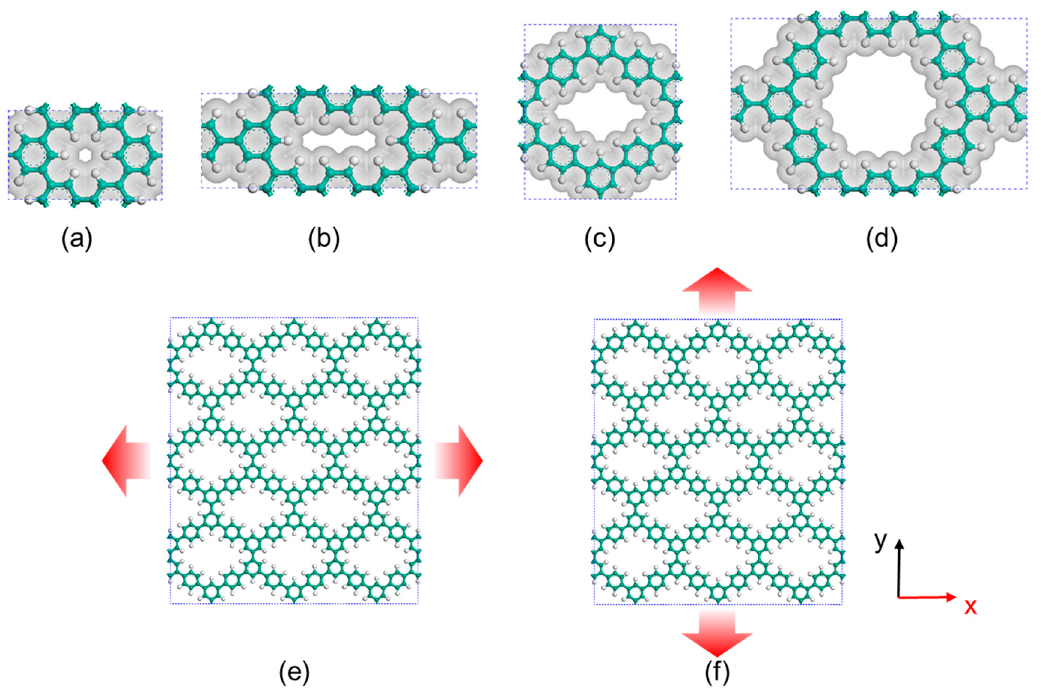
Figure 1. ( a – d ) Atomic structures and pore topology of PG-TP X ( X = 0, 1, 2, and 3, with pore areas of 0.8171, 6.6796, 28.4535, and 63.9226 Å 2 , respectively). Tensile model of a representative structure (i.e., PG-TP2) along the armchair ( e ) and zigzag ( f ) directions. Atom color: carbon-cyan, hydrogen-white. Van der Waals surfaces are shown in transparent cyan.